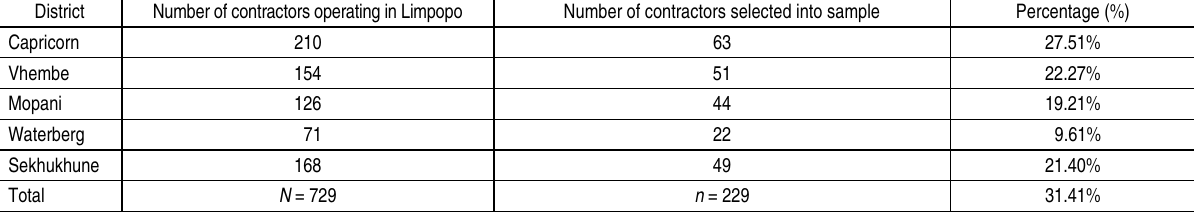
Table 1. Number of respondents selected for study